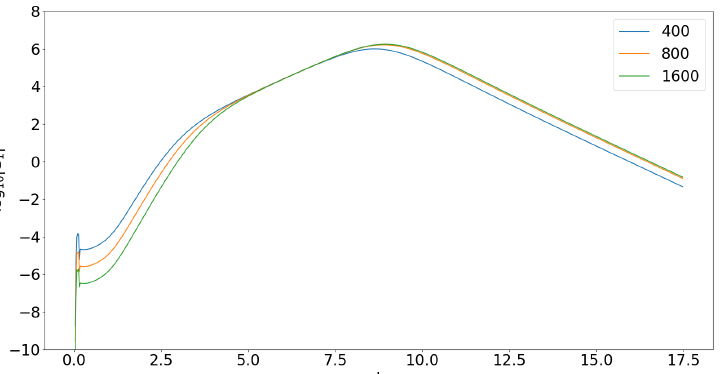
Figure 7. A convergence test for the constraint C 1 along the right boundary for the case of a single wave where a = 1.6769105 and λ =